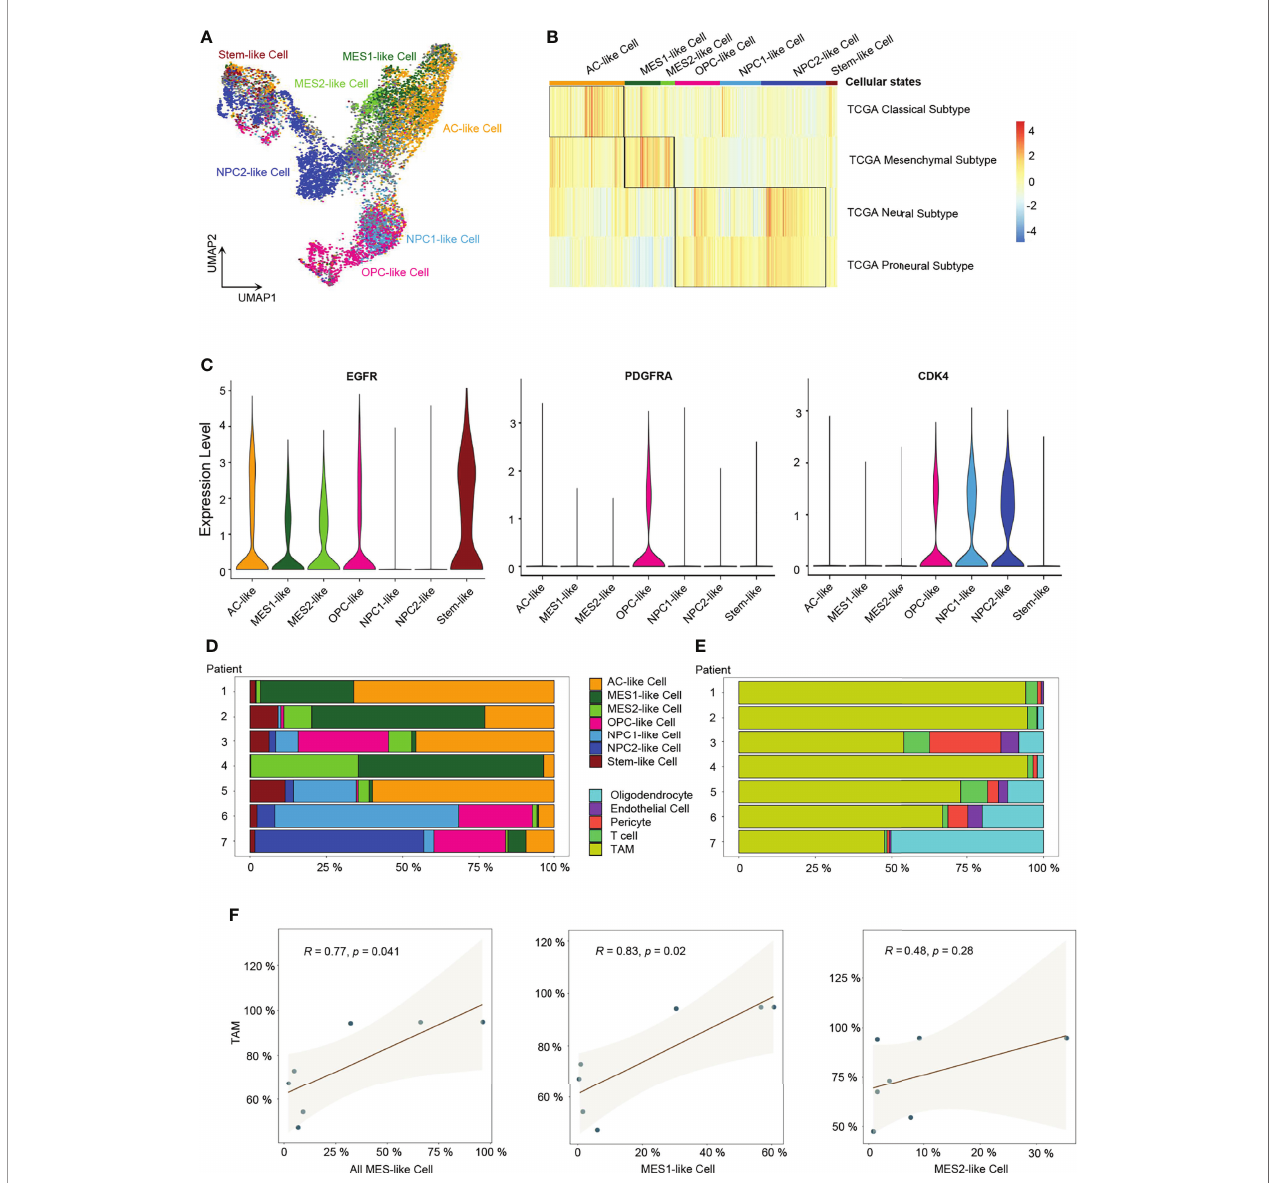
FIGURE 2 | Identi fi cation of six GBM tumor cell cellular states. (A) UMAP projection of the six GBM tumor cell cellular states and stem-like cells. (B) Heatmap of the four GBM TCGA transcription subtype scores. (C) Violin plot of EGFR , PDGFRA , and CDK4 expression level in different cellular states. (D) Composition ratio of the six cellular states in tumor cells. (E) Composition ratio of stromal cells in non-tumor cells. (F) Correlation between the number of MES-like cells and TAMs. See also Supplementary Figure 2 and Supplementary Table 3